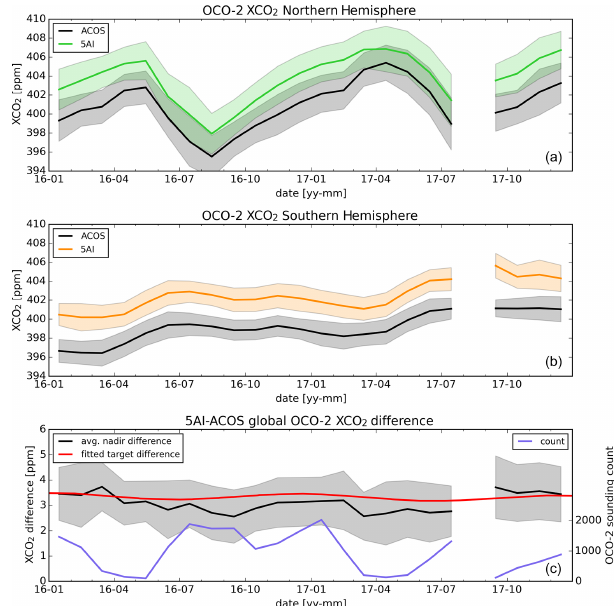
Figure 7. Temporal variation in 5AI and the raw ACOS B8r re- trieved X CO in the Northern Hemisphere (a) , Southern Hemi- 2 sphere (b) , and the global difference (c) . Panel (c) compares 5AI– ACOS difference for nadir and target